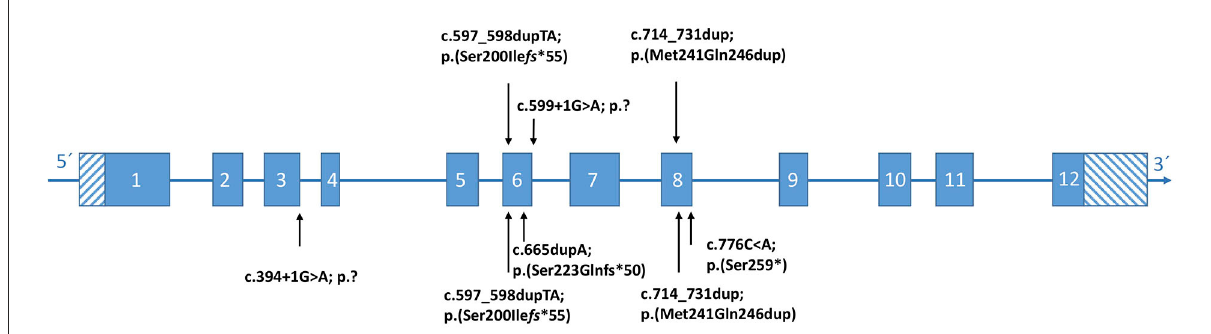
FIGURE3 Position of KPTN (NM007059.4) variants identified in this study (top) , with respect to the affected exon. (Bottom) Reported pathogenic variants according to the